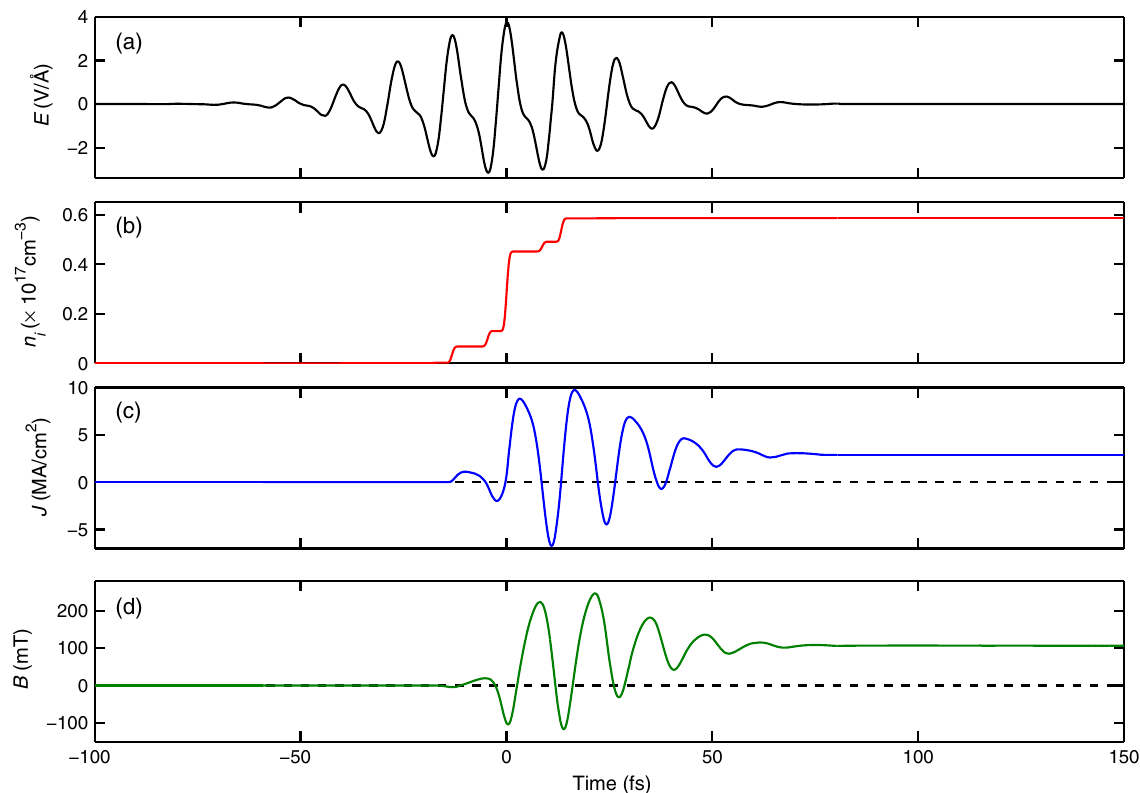
FIG. 2. Temporal dynamics relating the electric field excitation, gas ionization, current generation, and magnetic field induction. (a) An exemplary ω = 2 ω electric field waveform at the beam waist. (b) Growth of the ionized population density when this field is incident on a hydrogen gas target with a density n ¼ 10 17 cm − 3 . (c) The current density dynamics that occurs as the excited population interacts with the remainder of the laser pulse. (d) The magnetic field produced by this current